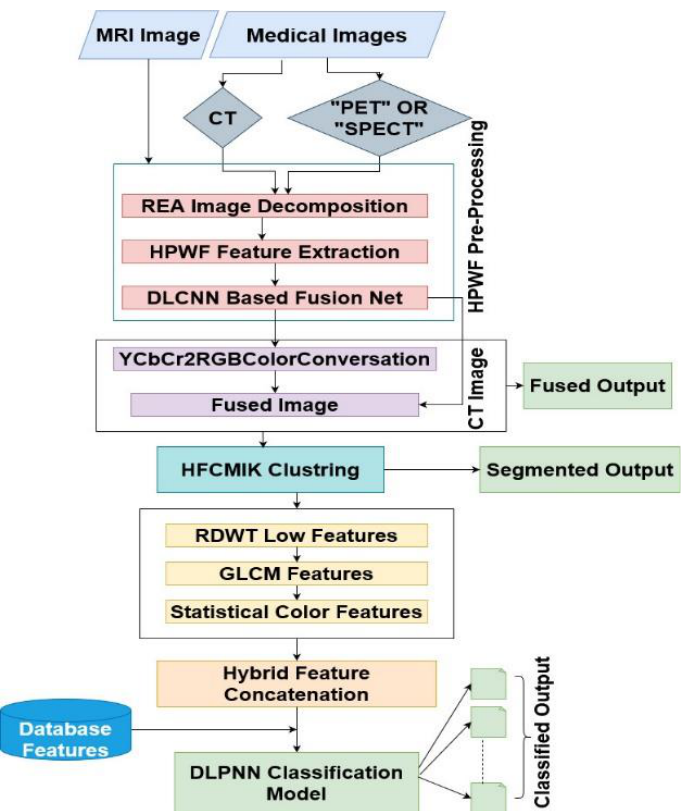
Figure 1. Segmentation and classification model for a proposed brain tumor fusion (MRI: magnetic resonance imaging, CT: computed tomography, PET: positron emission tomography, SPECT: single photon emission computed tomography, REA: robust edge analysis, HPWF: hybrid probabilistic wiener filter, DLCNN: deep learning convolutional neural networks, HFCMIK: hybrid fuzzy C-means integrated K-means, RDWT: redundant discrete wavelet transform, GLCM: gray-level cooccurrence matrix, DLPNN: deep learning probabilistic neural